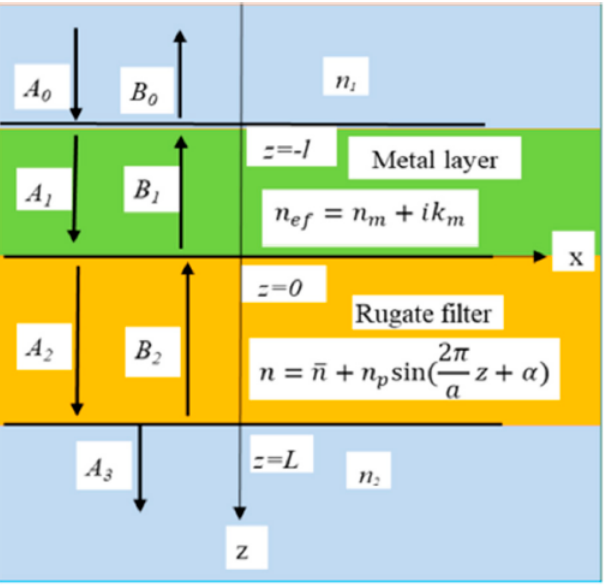
Figure 1. Schematic of the “metal layer–rugate filter (RF)” structure together with directions of the light beams propagating in the system and the refractive indices of the constituent